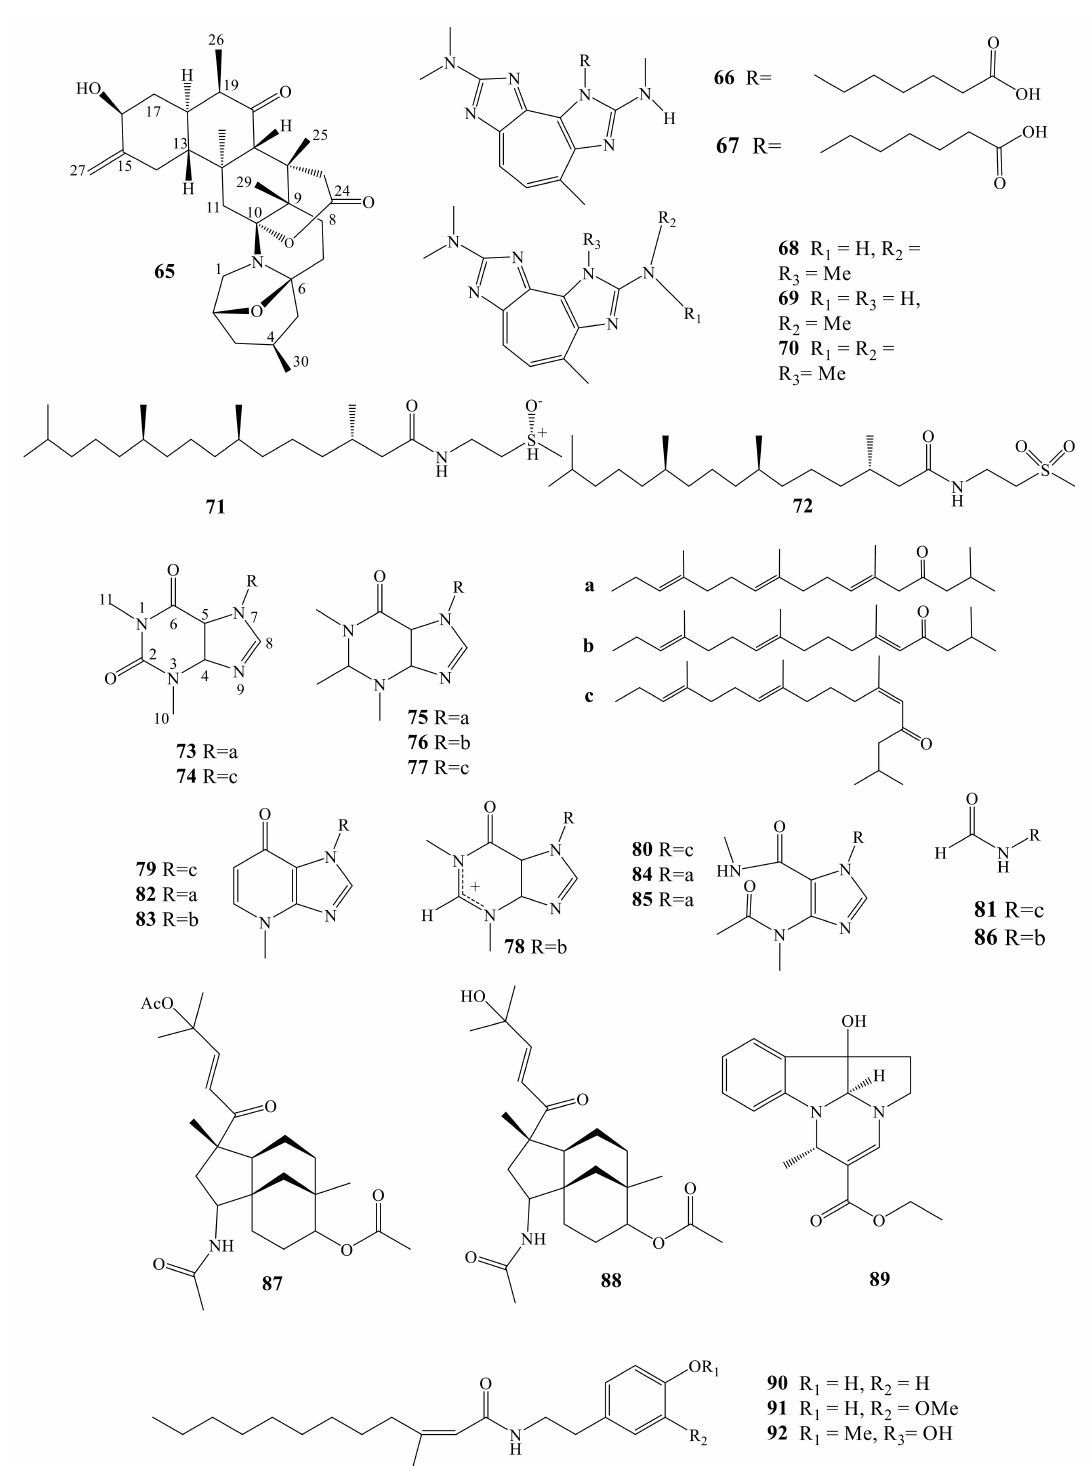
Figure 7. Terpenoidal alkaloids ( 65 – 92